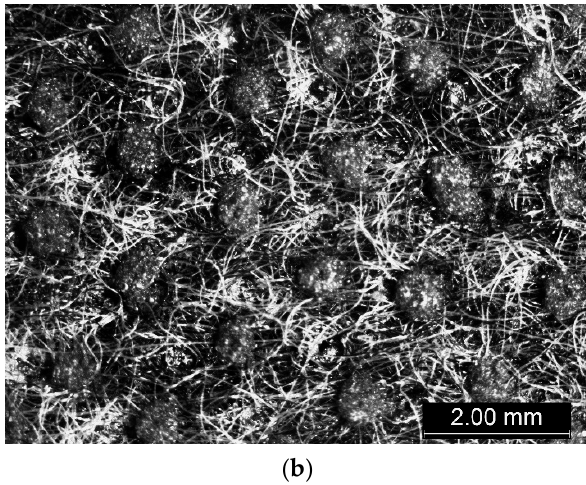
Figure 2. ( a ) Non-woven interlining; ( b ) microscope views of non-woven Interlining.